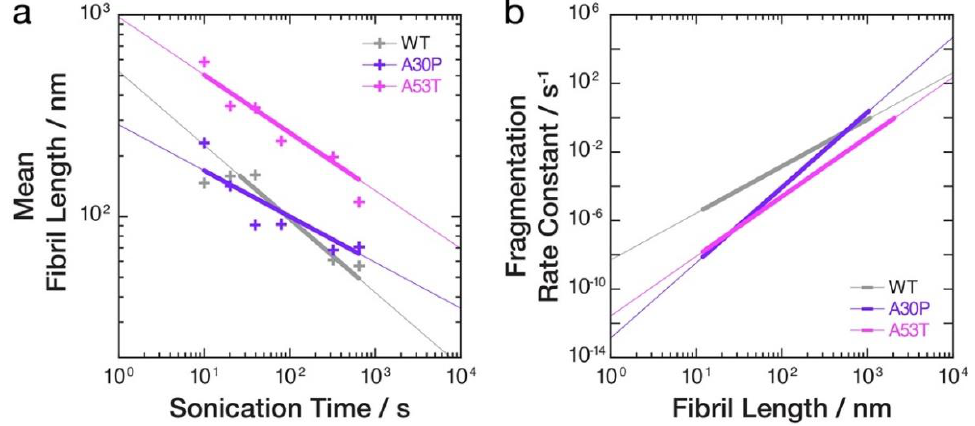
Figure 4. Comparative analysis of the relative stabilities of WT, A30P and A53T α-synuclein amyloid fibrils toward sonication-induced fragmentation. ( a ) The decay of experimentally observed mean lengths (+) as a function of sonication time duration is shown in a log–log plot together with the best-fit pure fragmentation model lines [26]. The thicker portion of the lines denotes the time ranges where the best-fit asymptotic lines describing characteristic length decay have likely been reached in the imaging experiments (the time ranges where the best-fit pure fragmentation model is likely reliable in describing the experimentally observed length decay, t > t s in Equation (1)). ( b ) The fragmentation rate constants, B ( x ), obtained from the best-fit pure fragmentation models are shown in a log–log plot as functions of fibril lengths, x . The thicker portion of the lines denotes the range of fibril lengths observed experimentally on the AFM images.